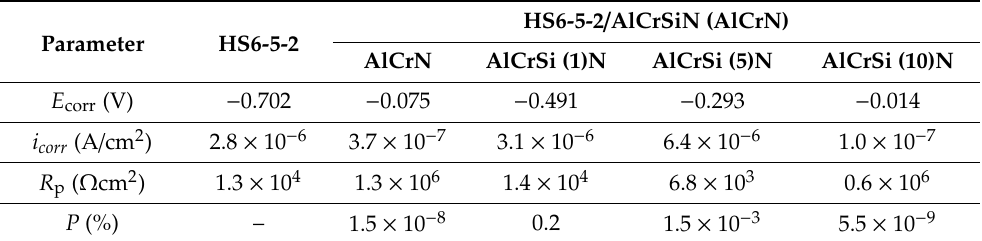
Table 3. Electrochemical parameters estimated for the HS6-5-2 and HS6-5-2/AlCrSiN systems.